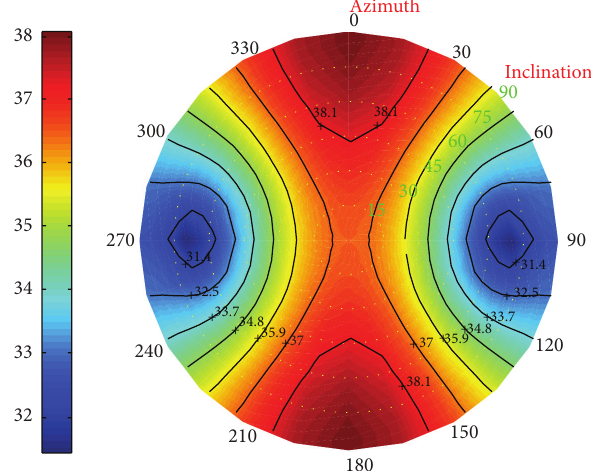
Figure 25: Risk distribution of collapse pressure under coupling of thermo-fluid-solid.